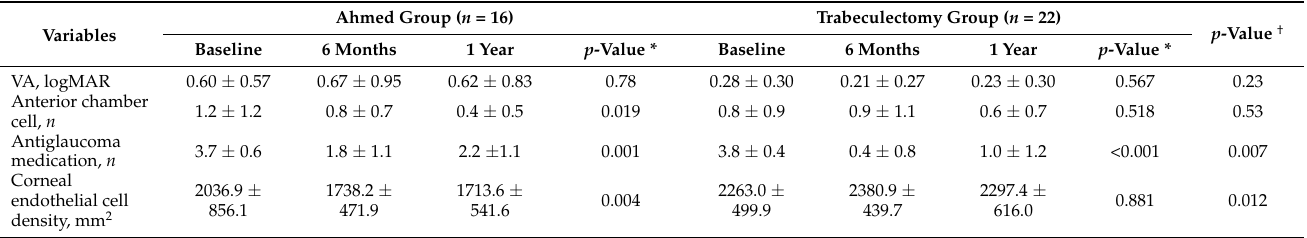
* Comparison between data at baseline and postoperative 1 year. † Comparison between the two groups at postoperative 1